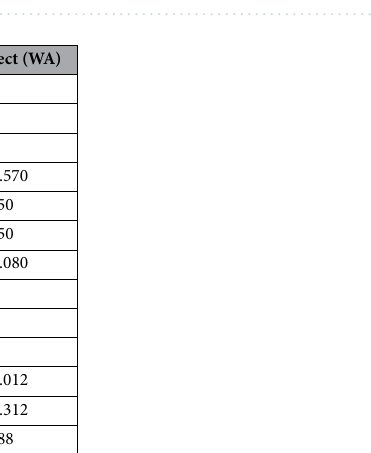
Figure 9. Accuracy of the design using probability plots by RSM analysis ( a ) initial water absorption of B-FCB ( b ) water absorption of B-FCB.